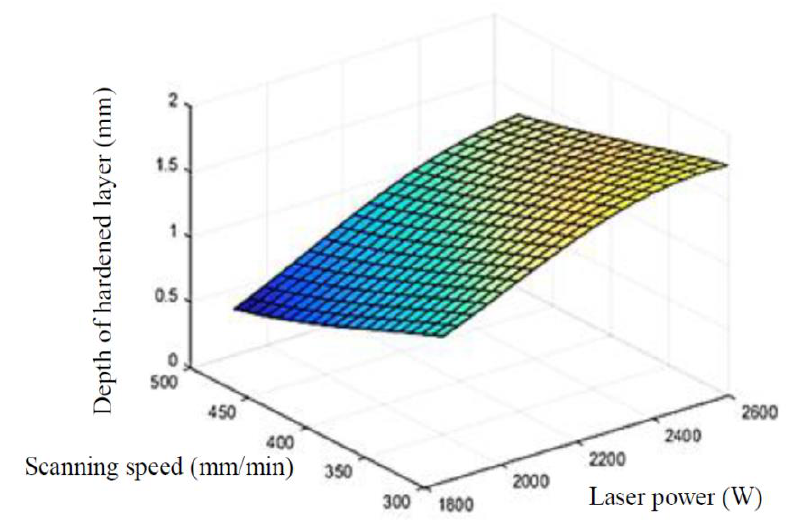
Figure 10. Kriging models for depth of hardened layer of scanning speed and laser power.